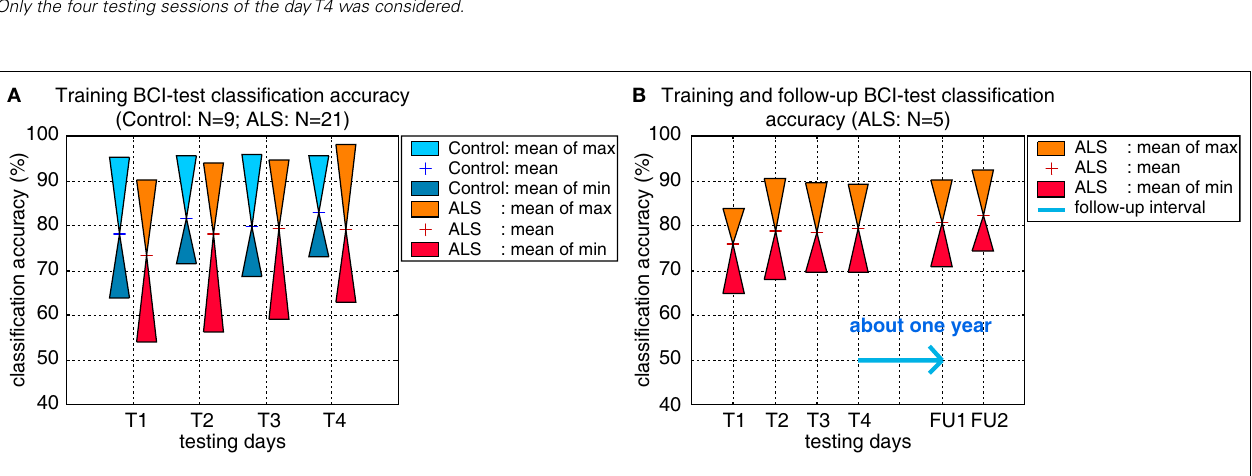
FIGURE 4 | (A) Target and non-target single-sweep classifi cation accuracy (%) of the two groups, Control and ALS, during training BCI-test; (B) target and non-target single-sweep classifi cation accuracy (%) of fi ve ALS patients during training and follow-up